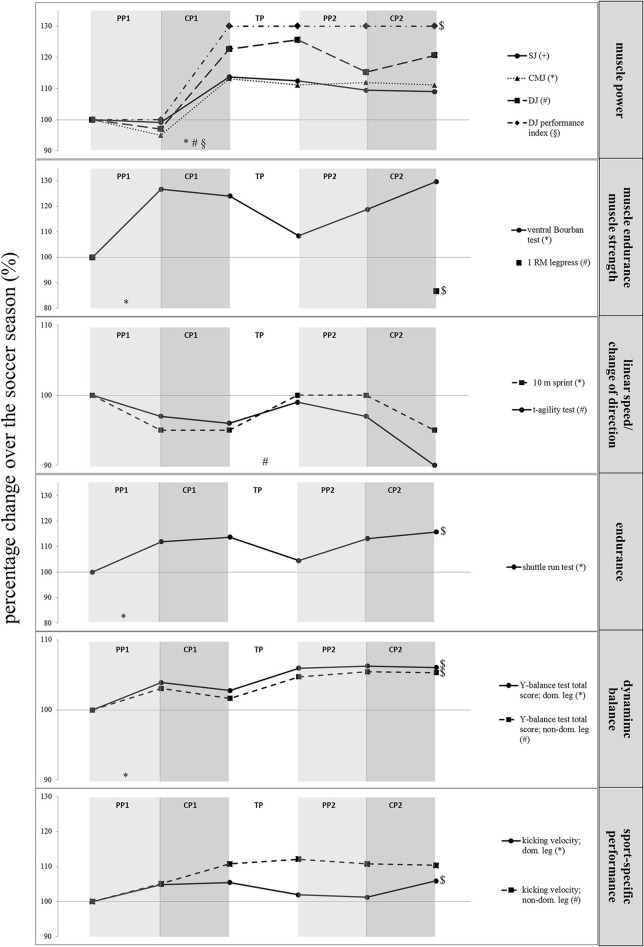
Seasonal changes in physical fitness in female elite young soccer players. For better visual inspection, the vertical axis was not scaled similarly in all charts. Note that improvements in linear sprint and T-agility performances (time) correspond to decreases in percentage changes. CP1, competition period 1 (12 weeks); CP2, competition period 2 (15 weeks); PP1, preparation period 1 (4.5 weeks); PP2, preparation period 2 (8 weeks); TP, transition period (4 weeks); *,+,#,§Significant differences; $significant differences between pre (T1) and post-season (T6).